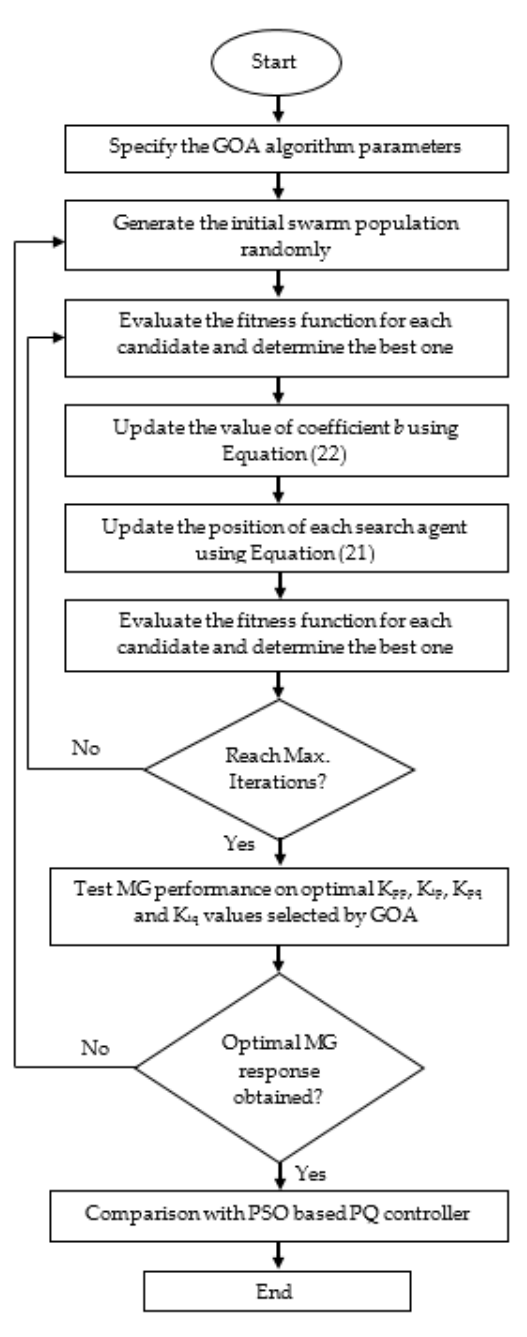
Figure 5. Proposed Methodology.